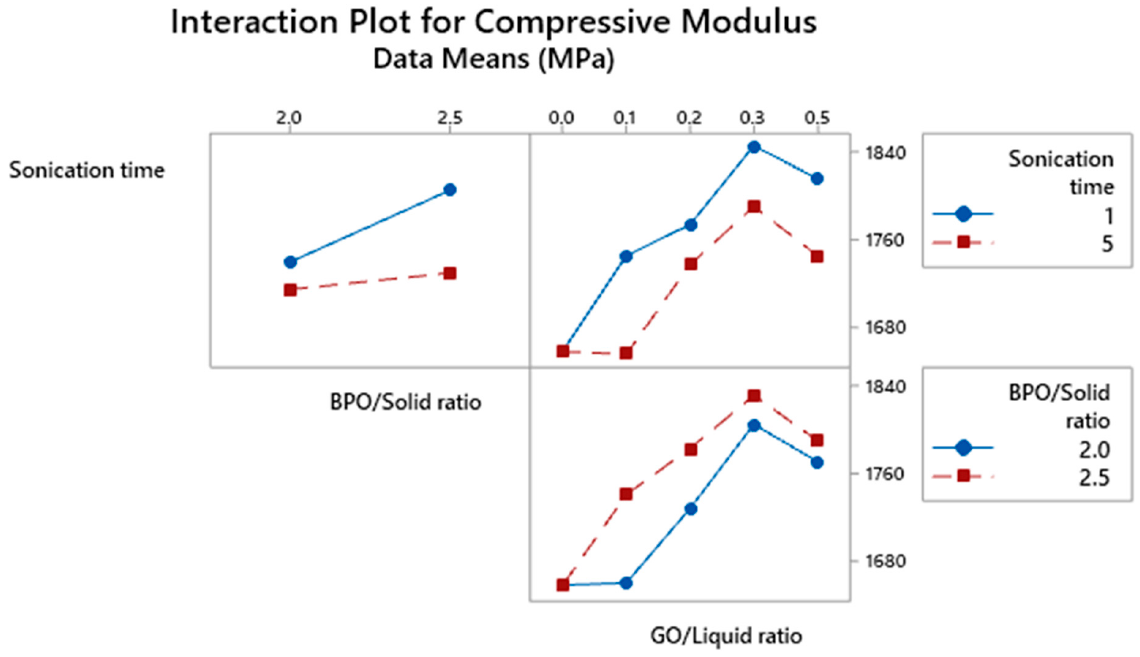
Figure 7. Interaction plot between the effect sonication time, GO/liquid ratio, and BPO/solid ratio for the variable compressive modulus .